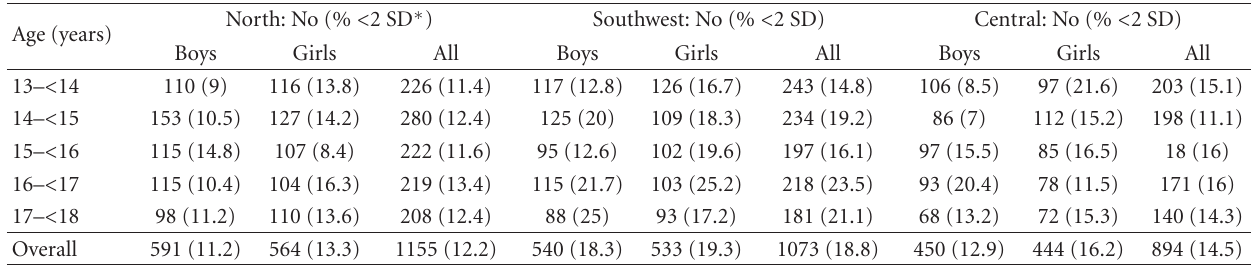
Table 2: Regional prevalence of short stature in